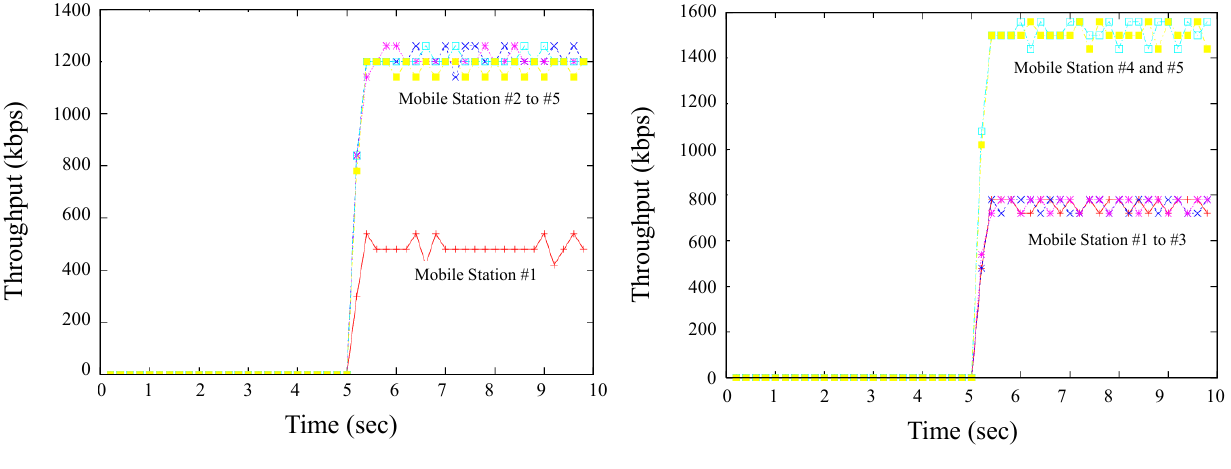
Figure 7. DRRF Throughput. a. (left) with 5 flows: MS MS and MS with traffic priority 2 and MS 1 1